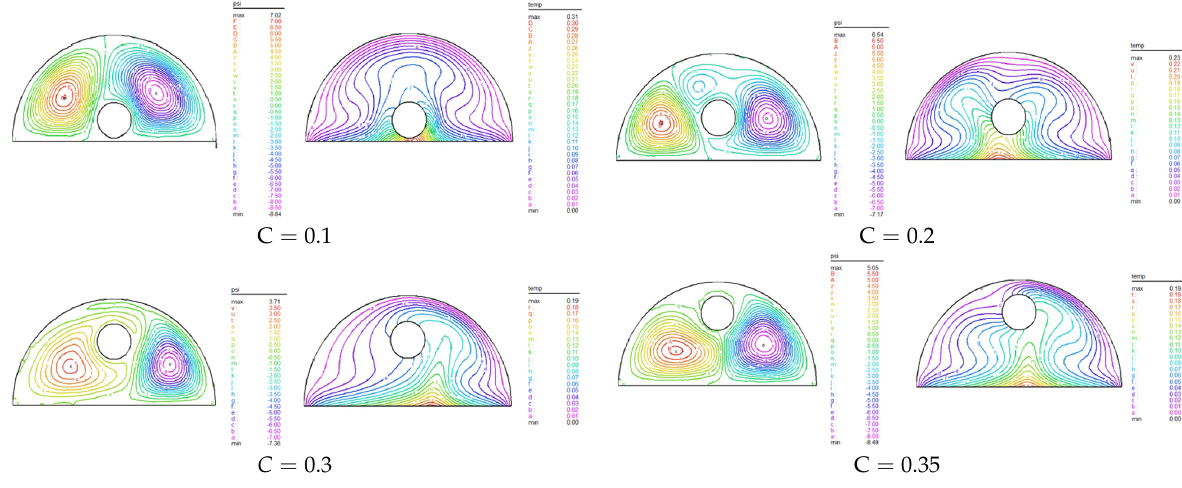
Fig. 7. Streamlines and isotherms; Ra = 10 5 , γ = 0 ◦ , Ω =